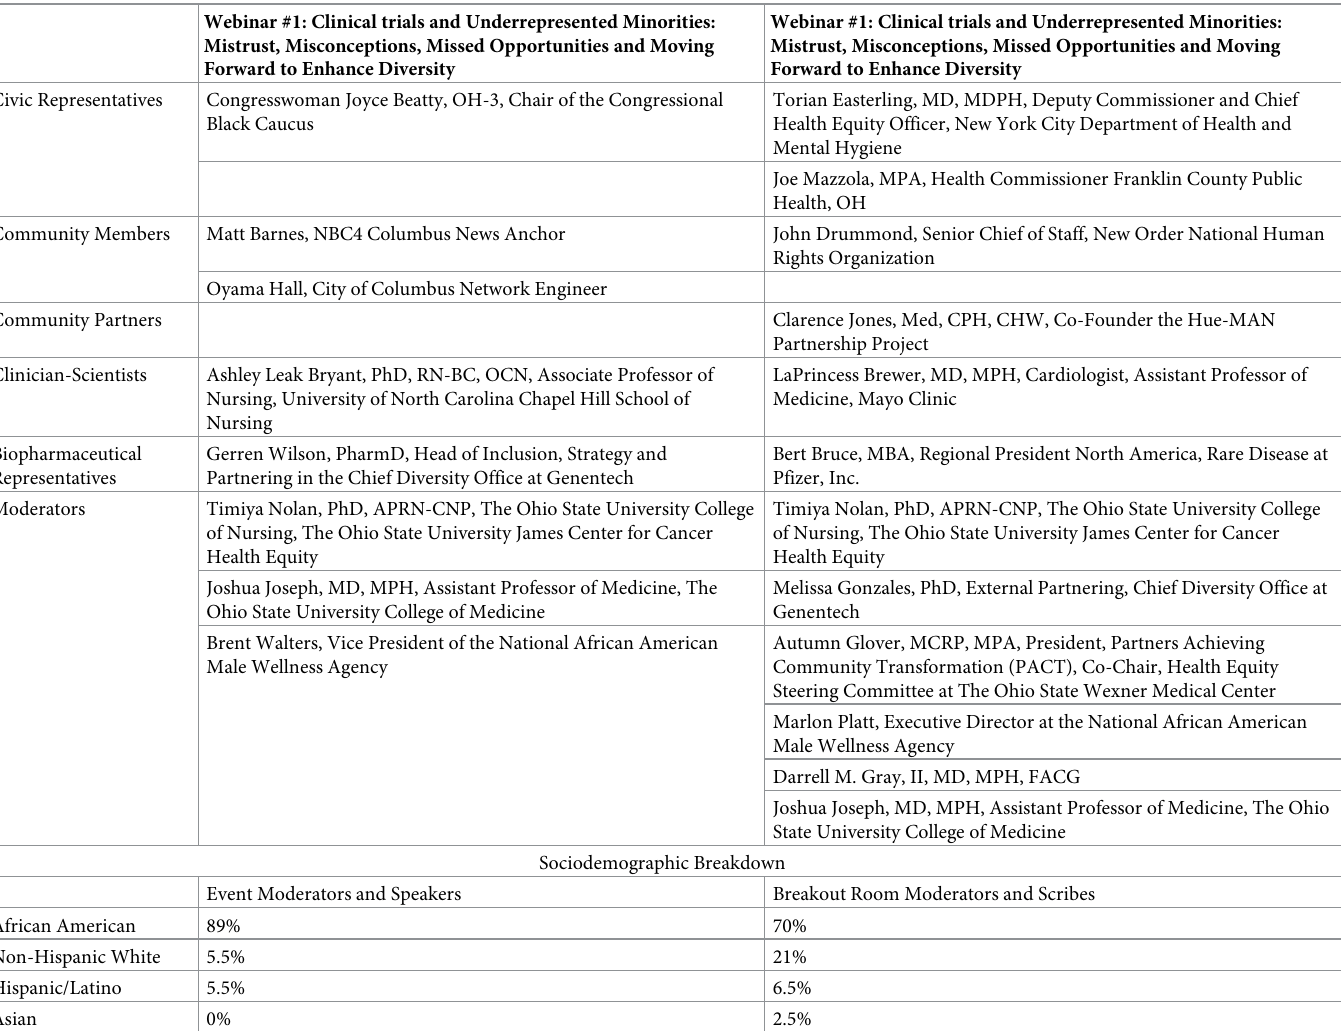
Table 1. Health Equity through Diversity webinar series– speakers and moderators . Webinar #1: Clinical trials and Underrepresented Minorities: Mistrust, Misconceptions, Missed Opportunities and Moving Forward to Enhance